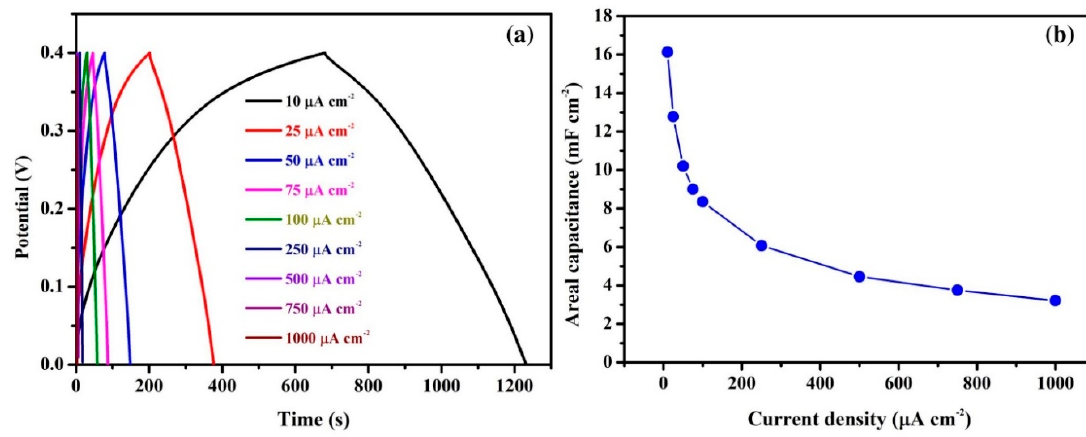
Figure 4. Galvanostatic charge-discharge (GCD) curves at various current densities ( a ) and calculated areal capacitance values with respect to various current densities ( b ) for sheet-like ZnCo 2 O 4 .